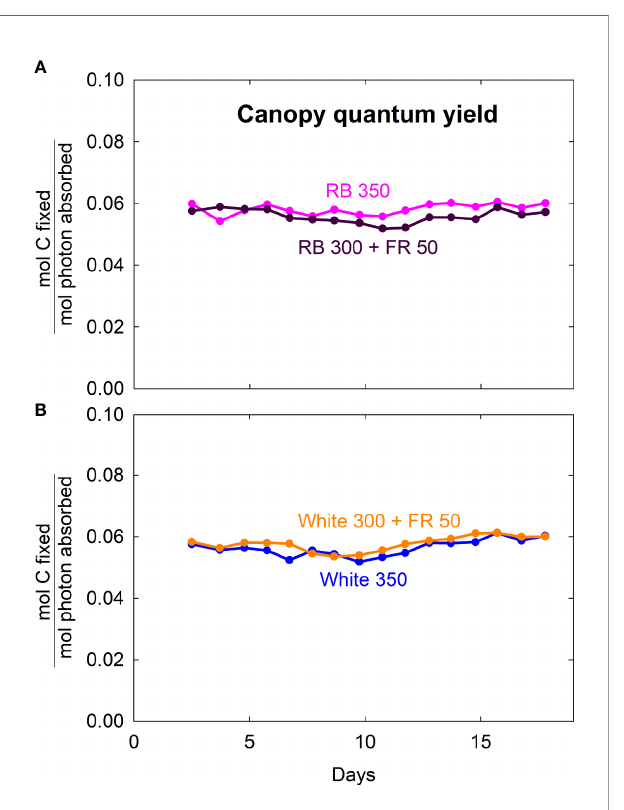
FIGURE 7 | Canopy quantum yield (moles of carbon fi xed in gross photosynthesis per mole of photons absorbed from 400 to 750 nm) of lettuce grown under red/blue (RB) and white light, with or without far-red (FR) substitution. The numbers following each type of light ( e.g. RB 350) indicate photon fl ux density in m mol m − 2 s − 1 .